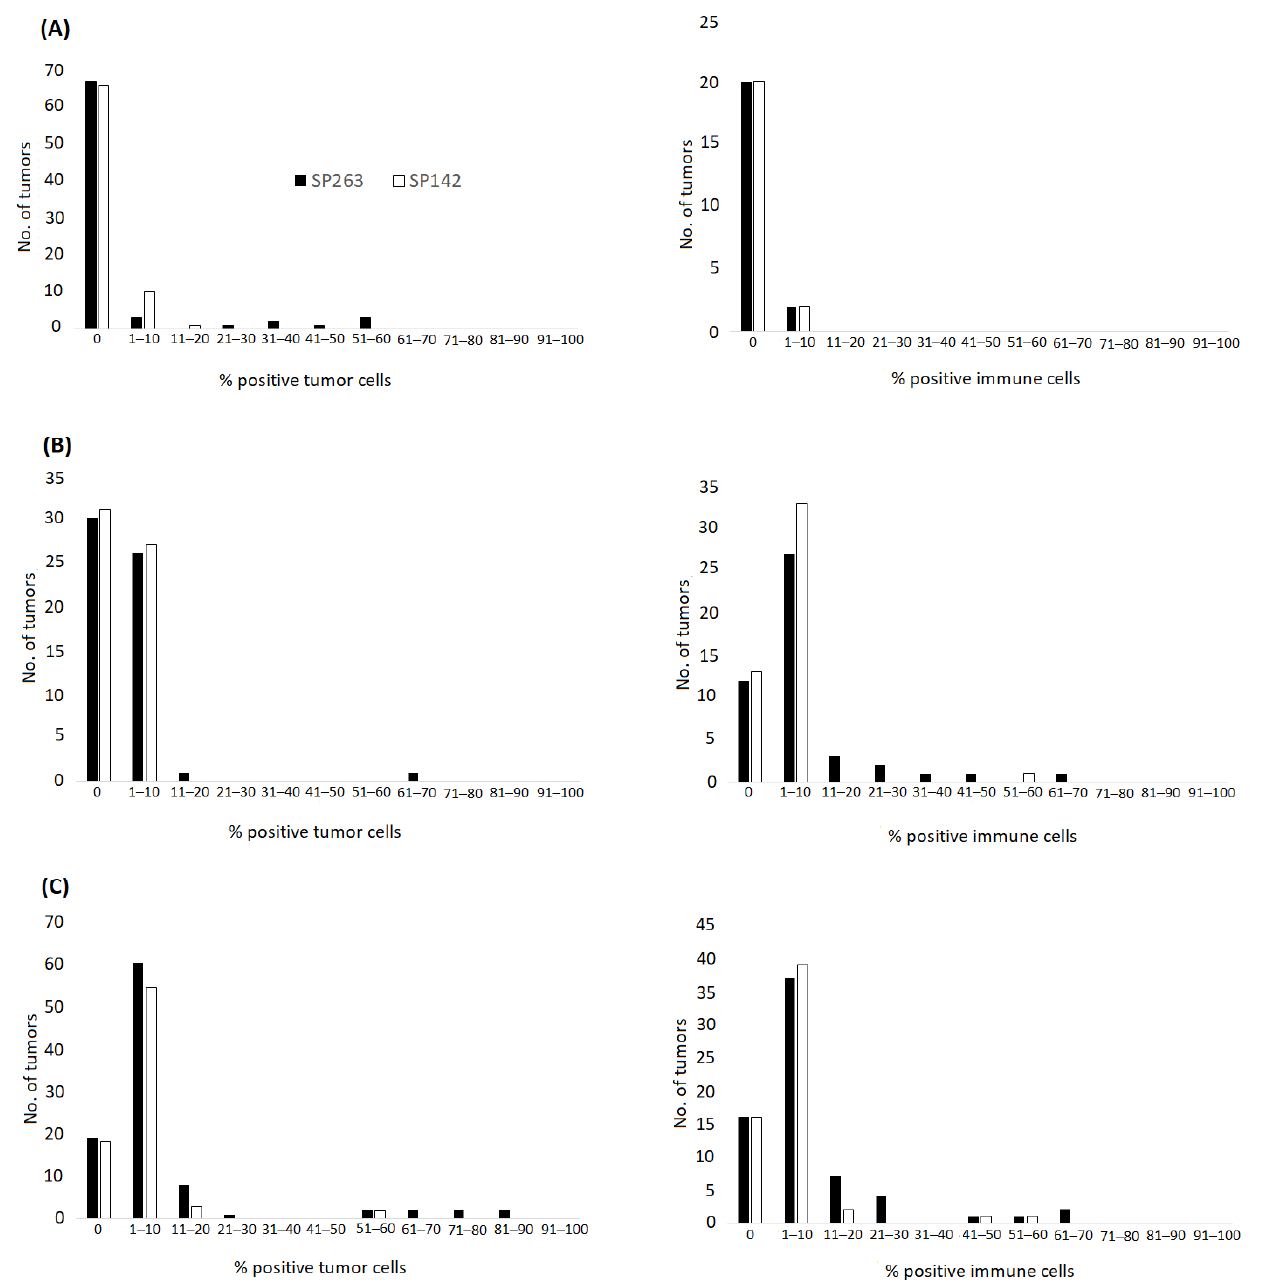
Figure A1. Distribution of PD-L1 immunoreactivity in tumor and immune cells with SP142 and SP263 assays for ( A ) chondrosarcoma, ( B ) liposarcoma and ( C ) undifferentiated pleomorphic sar- coma.